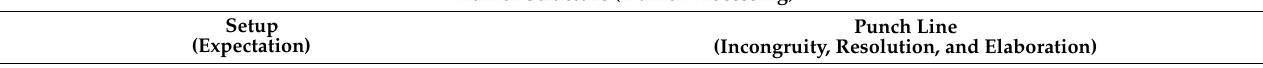
Table 1. An example of a two-element joke. Humor Structure (Humor